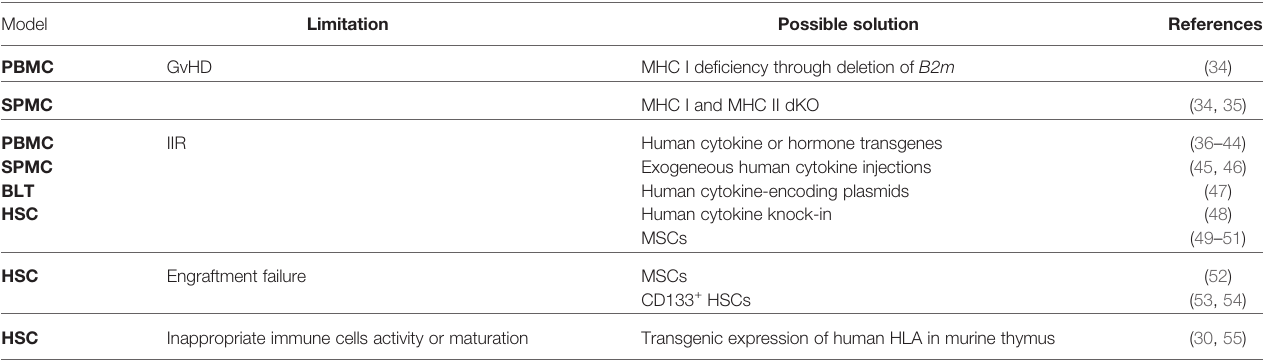
TABLE 2 | Limitations of humanized mouse models and how they can be